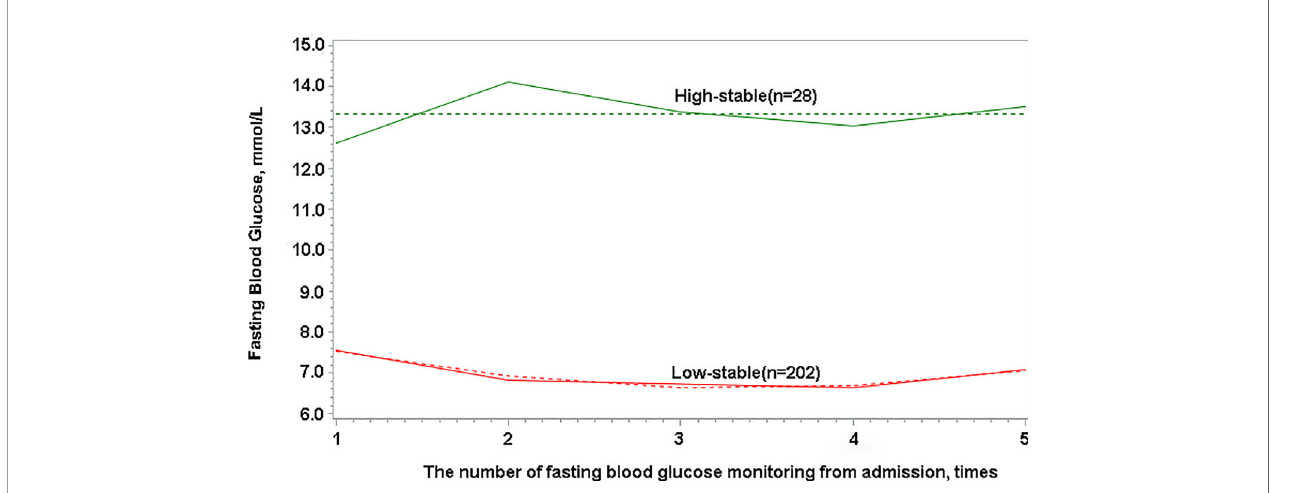
FIGURE 2 | Fasting blood glucose trajectories with low-stable and high-stable patterns based on longitudinal change in fasting blood